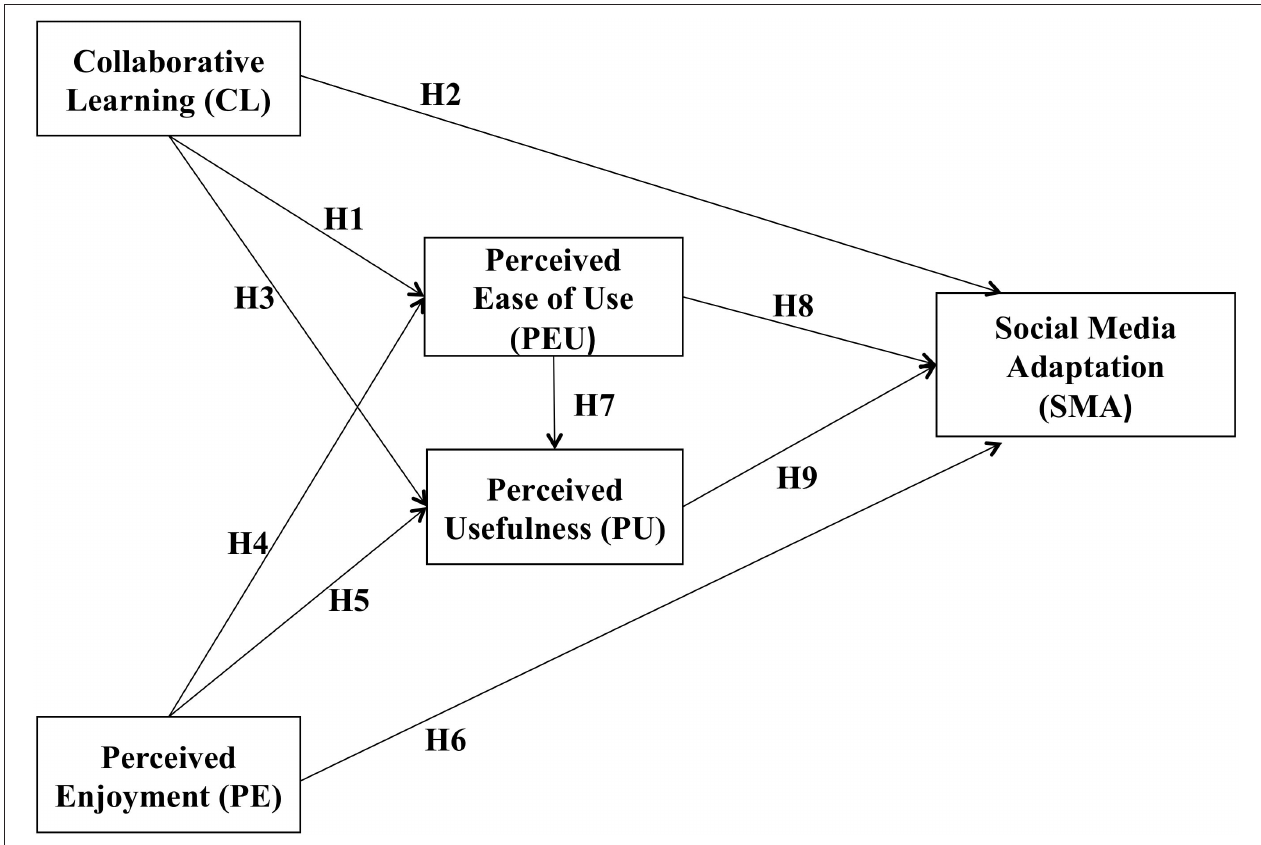
FIGURE 2 | Conceptual model based on TAM and